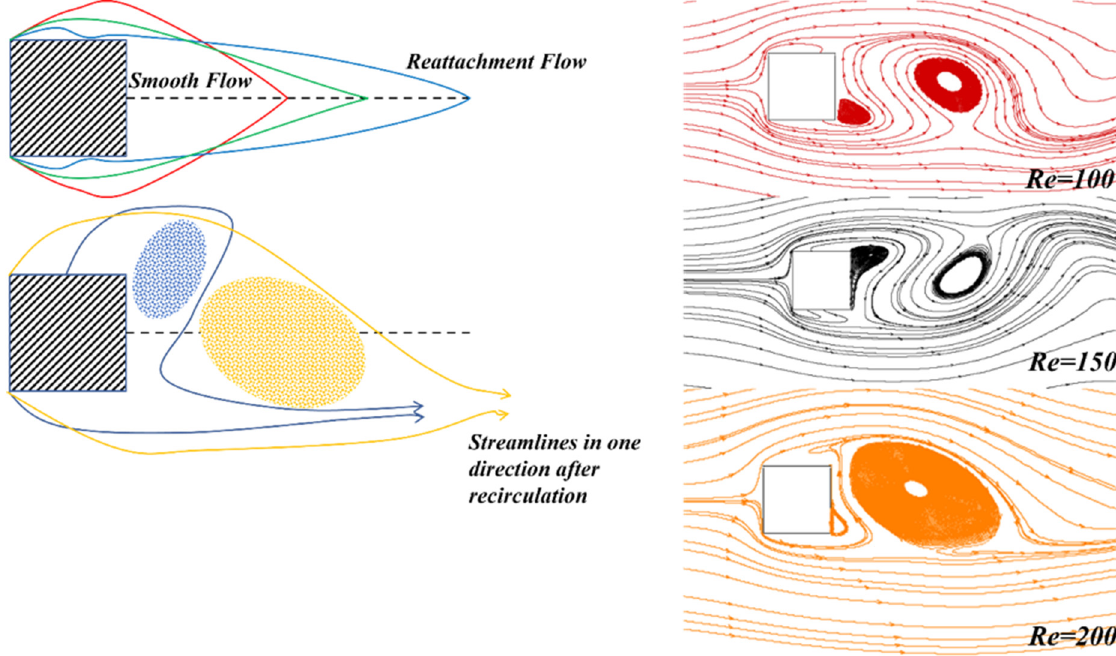
Figure 8. Pictorial representation of the streamlines representing the transition along the stream- lines .